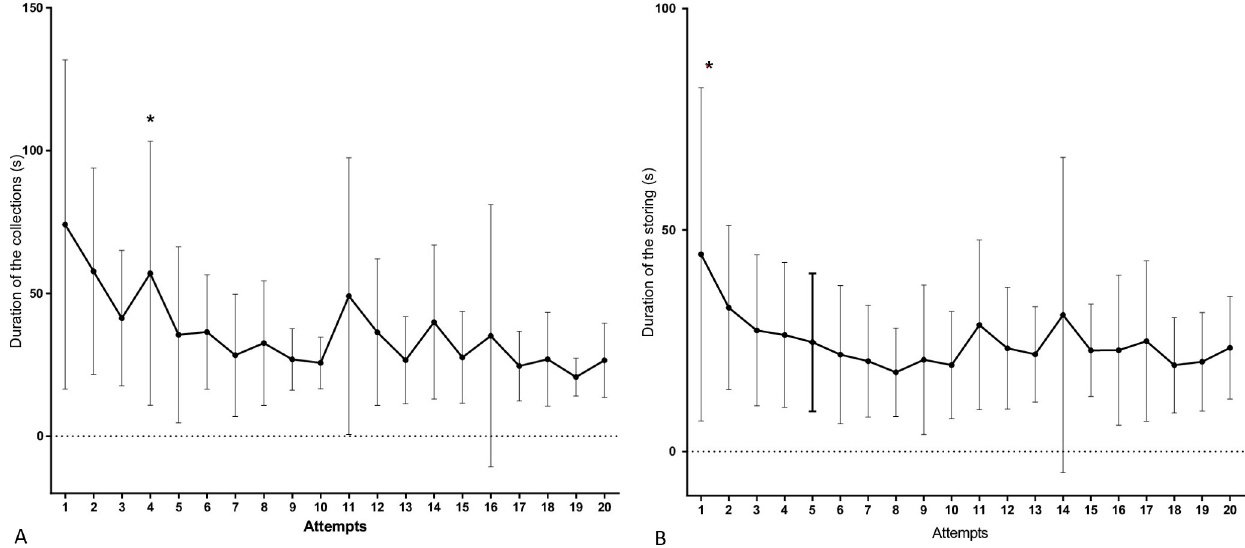
Fig 5. Multivariate analysis of the data. (A) Analysis acquired for the duration of the collections in both species (canine and swine) throughout the attempts in this study. (B) Analysis acquired for the duration of the storing process in both species (canine and swine) throughout the attempts in this study. ( � ) Moment when subsequent evaluations of this variable are stabilized—plateau (for the duration of collection and storing processes).